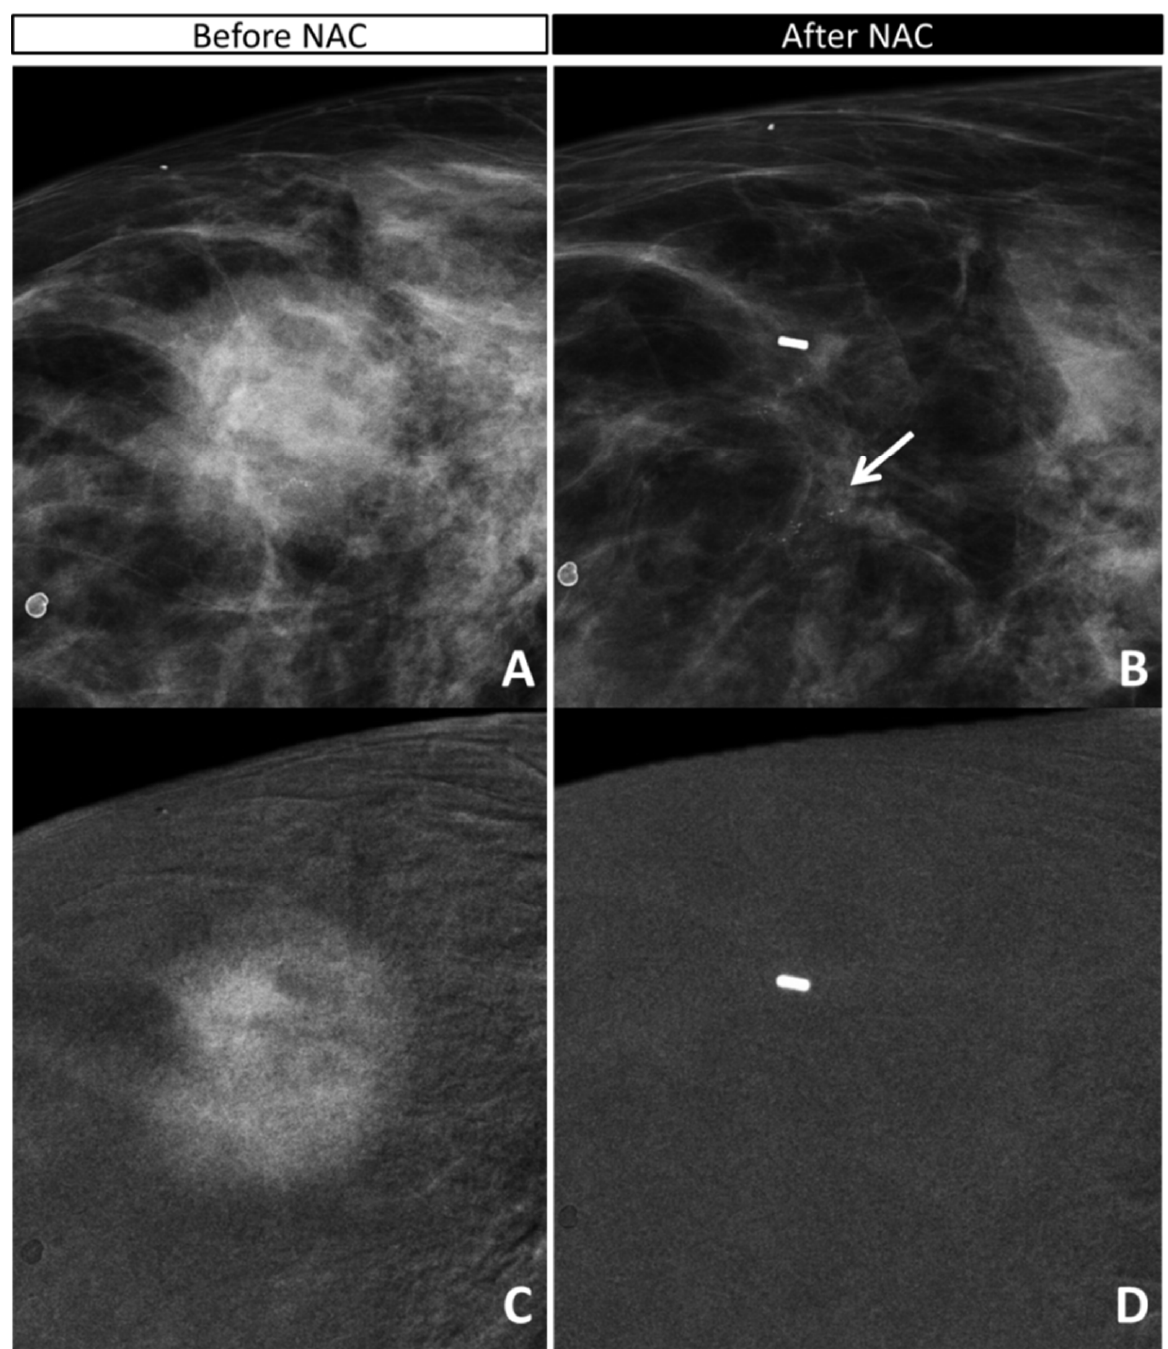
Figure 1. False positive for the combined evaluation and true negative for the CE evaluation: 67-yo woman with IDC G2 HER2+ with opacity and inner pleomorphic calcifications in the outer quadrant of the right breast ( A , C : canio-caudal (CC) low-energy image). The in situ component was seen only on the surgical specimen. The opacity showed a strong mass enhancement before NAC ( C : CC recombined image). After NAC ( B : CC low-energy image; D : CC recombined image), the calcifications decreased slightly in size; remaining pleomorphic, they were considered pathological ( B , arrow); no residual enhancement was visible surrounding the marker placed in the tumor bed, in the site of the previous opacity. The analysis of the surgical specimen revealed a complete response ypT0.